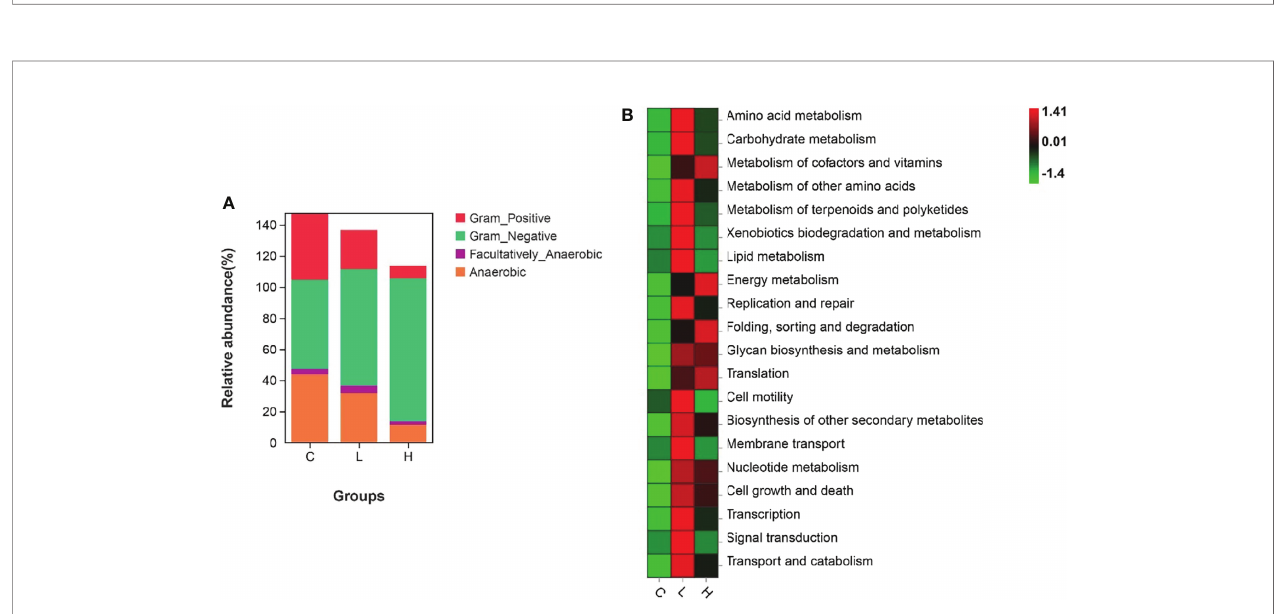
FIGURE 7 | Relative abundances of dominant bacterial phyla (A) and genera (B) in the intestine of channel cat fi sh after exposure to different concentrations of Del. C: 0 m g/L Del; L: 0.5 m g/L Del; H: 5 m g/L